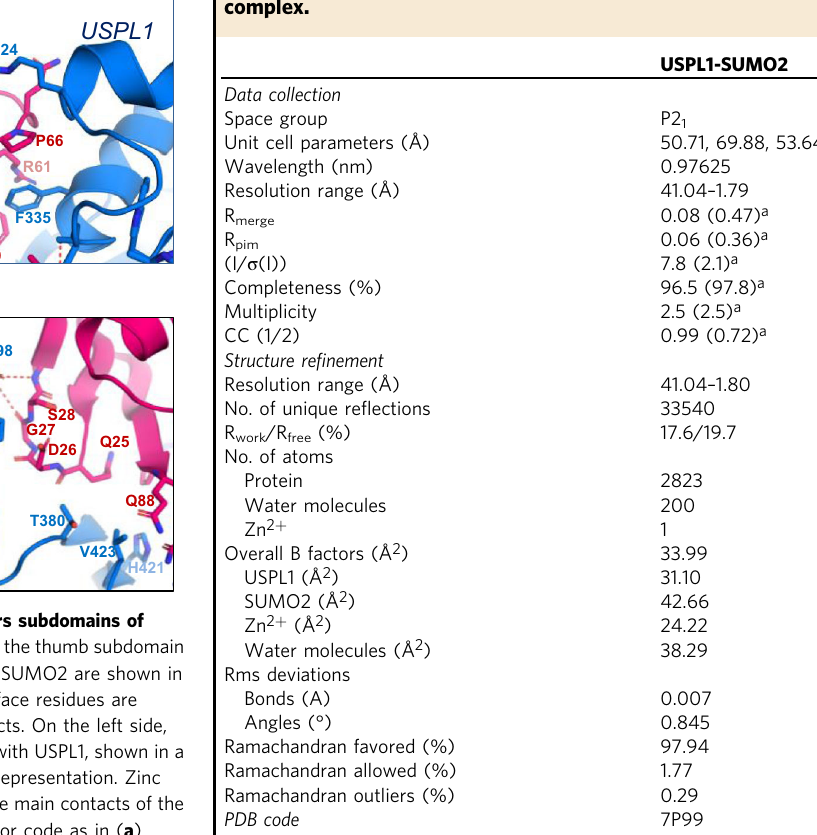
Table 1 Crystallographic statistics of the USPL1-SUMO2